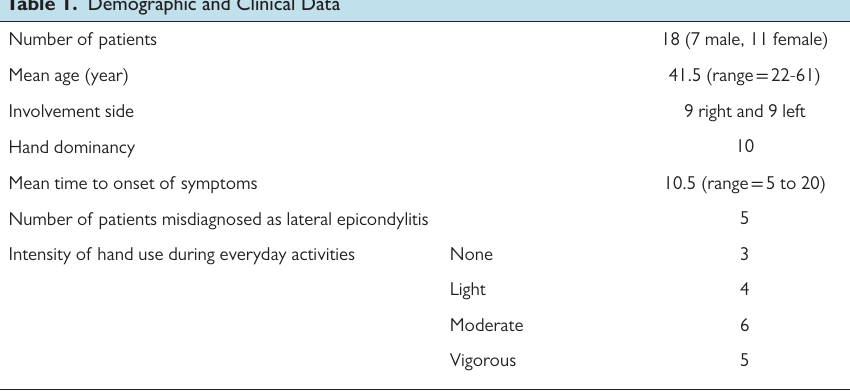
Table 1. Demographic and Clinical Data Number of